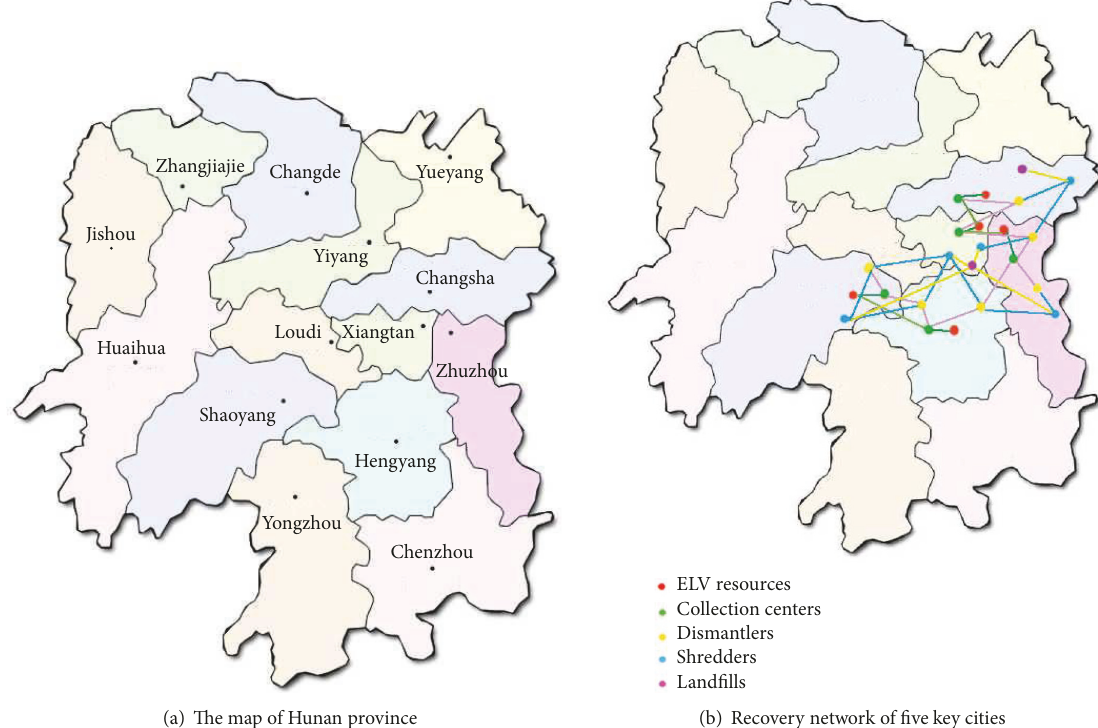
Figure 6: Recovery network in Hunan